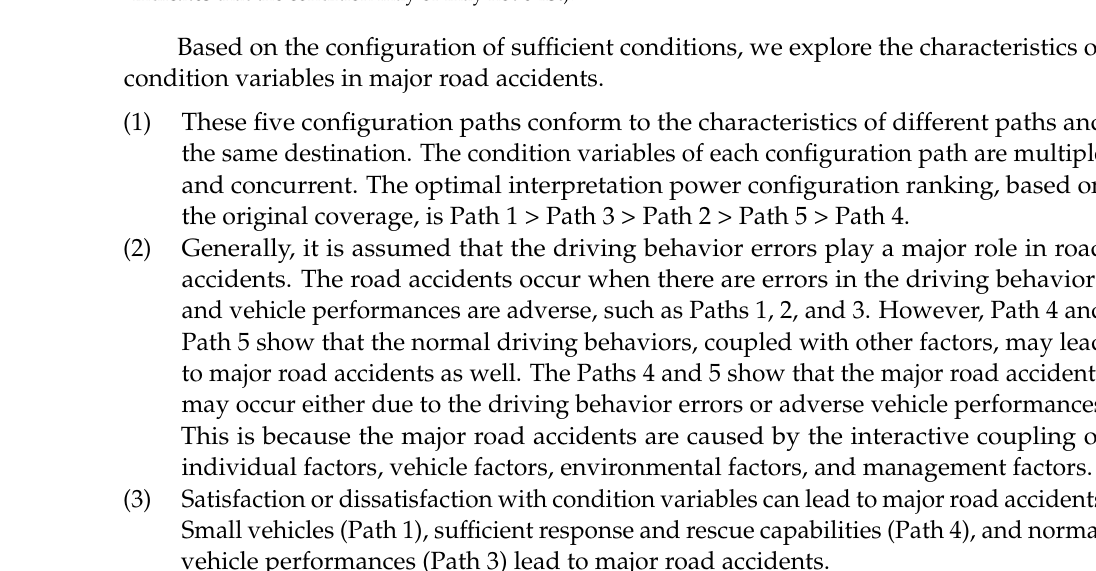
Table 3. The realization of the configuration of major road accidents by using